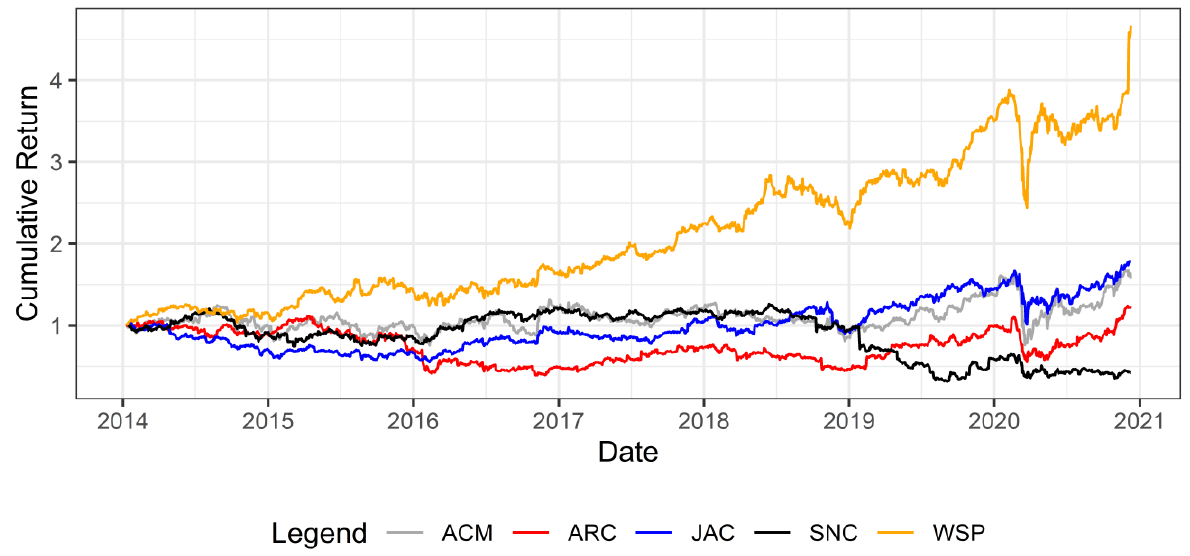
Figure 1. Accumulated return for the five largest consulting engineering companies in the world. Notes: Data from 9